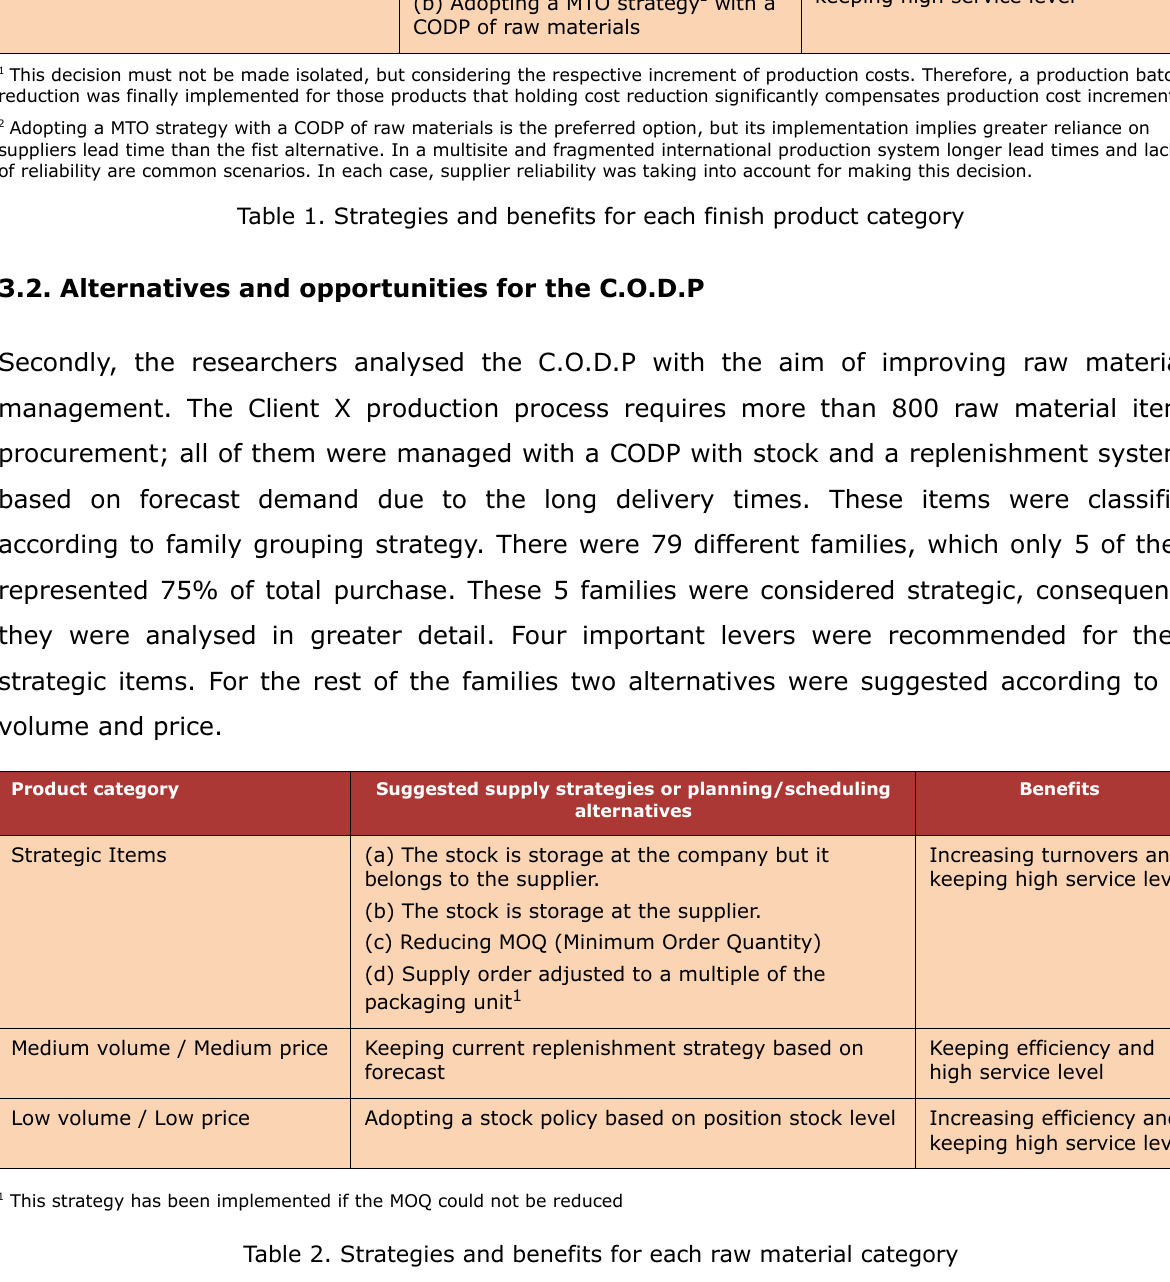
Table 2. Strategies and benefits for each raw material